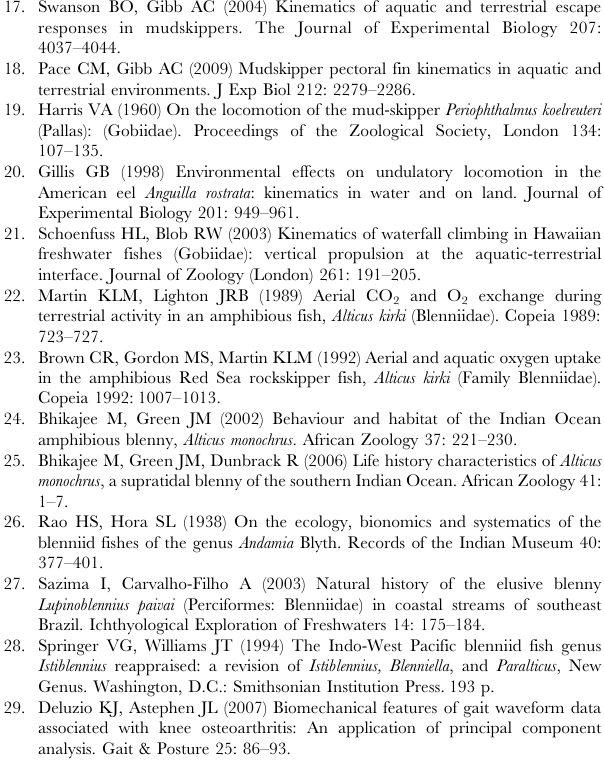
takes place in approximately 600 ms. This locomotor mode is similar to a hop, but the body is extended at a much higher velocity. Blennies can jump over 3 body lengths in one leap. 250 fps, and this sequence occurs within 700 ms. Plexiglas